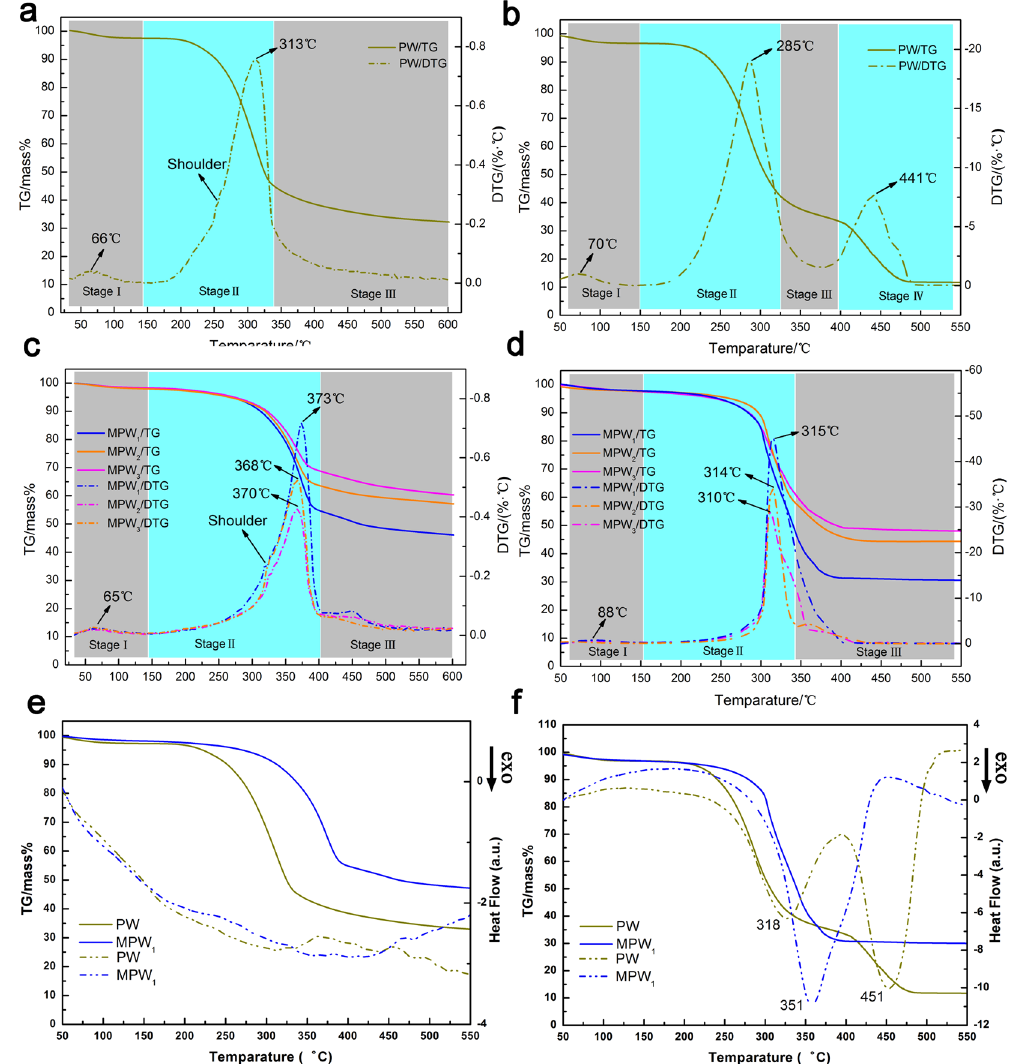
Figure 3. TG/DTG curves at heating rate of 20 °C/min of ( a , b ) PW and ( c , d ) MPW in nitrogen and air atmosphere, respectively. TG/DSC curves at heating rate of 20 °C/min of PW and MPW 1 in ( e ) nitrogen and ( f ) air